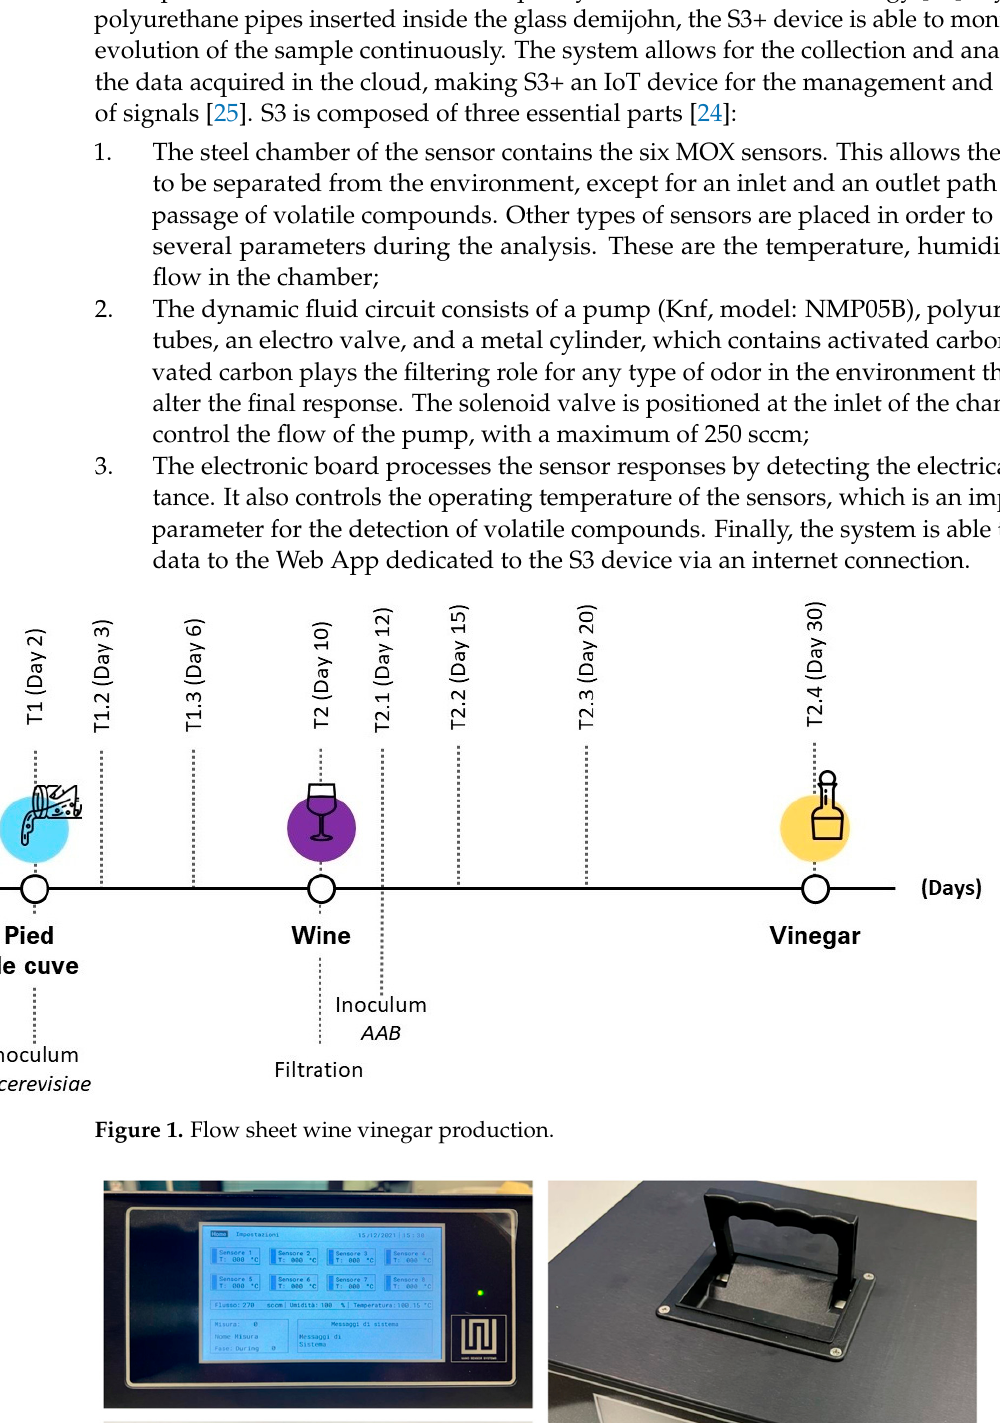
Figure 2. Small Sensory systems—S3+. The system allows for the collection and analysis of the data acquired in the cloud, making S3+ an IoT device for the management and control of signals. The sensor response is based on the change of its resistance over time caused by interactions with different kinds of volatile compounds or surrounding environments. The reactions between the oxygen species adsorbed on the surface of the sensor and the target molecules lead to the variation in the concentration of charge carriers in the sensing material, affecting its elec- trical conductance. This device has been already used with remarkable success in other